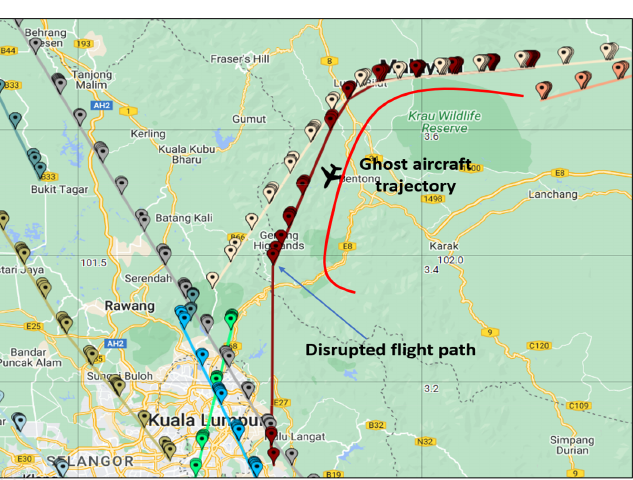
Figure 3. Ghost aircraft spoofing scenario at TMA